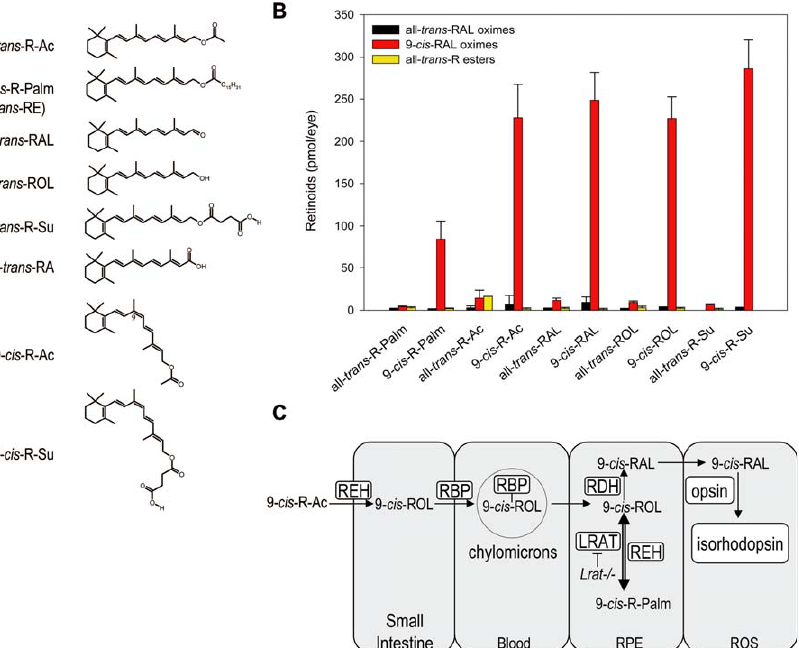
Figure 1. Retinoid Structures, Specificity of Retinoids in Regeneration of Visual Pigment, and Model of Absorption of 9- cis -R-Ac in Mammals (A) Structures of retinoids used for gavage studies. (B) Levels of all- trans -RAL oximes, 9- cis -RAL oximes (corresponding to formation of visual pigment isorhodopsin), and all- trans -REs in Lrat (cid:2) / (cid:2) mouse eyes gavaged with 5 mg of each retinoid before 48–72 h dark adaptation ( n (cid:4) 3, data shown with standard deviation [SD]). (C) Model of absorption of 9- cis -R-Ac in mammals. DOI: